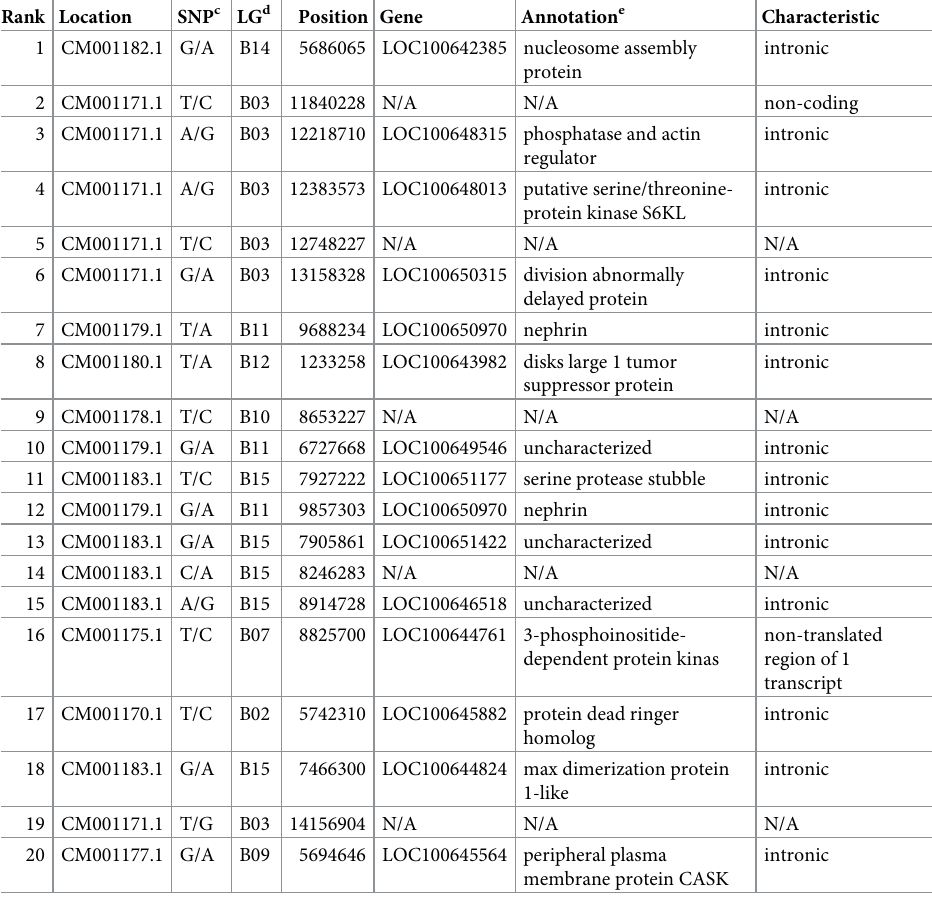
Table 4. Top 20 SNPs associated with infection intensity in samples having Axis.1 <